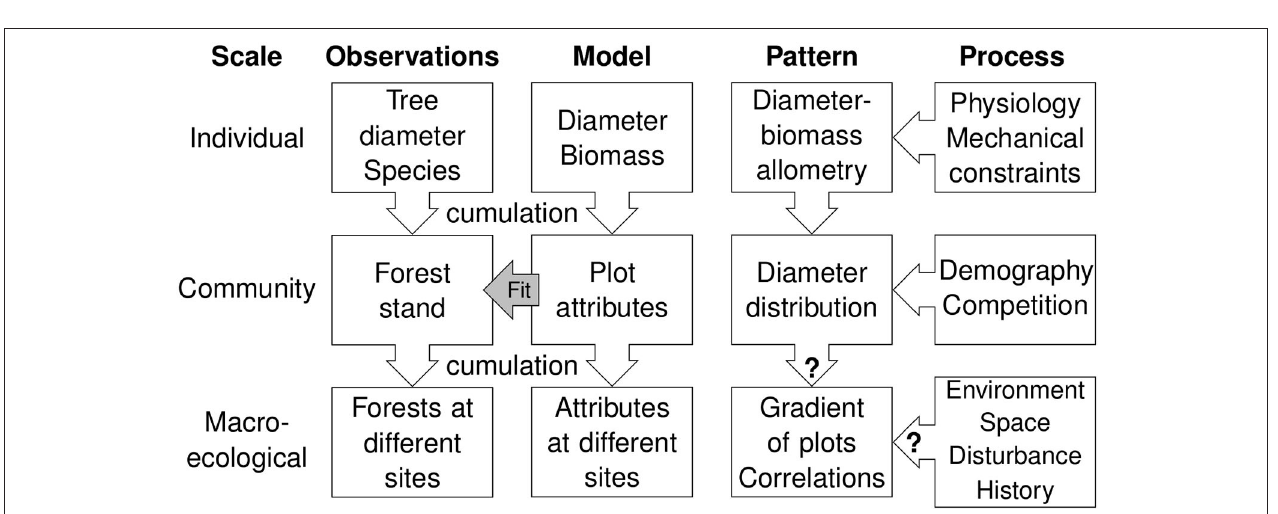
FIGURE 6 | Conceptual view of the different patterns at different scales (from the individual to the macroecological level), the process that possibly drive these patterns, the observations from which the patterns arise, and the models to predict observations. Model analysis is used to generate an obvious pattern at macroecological level that is inherited from patterns at lower levels and assess if this obvious pattern differs from the observed